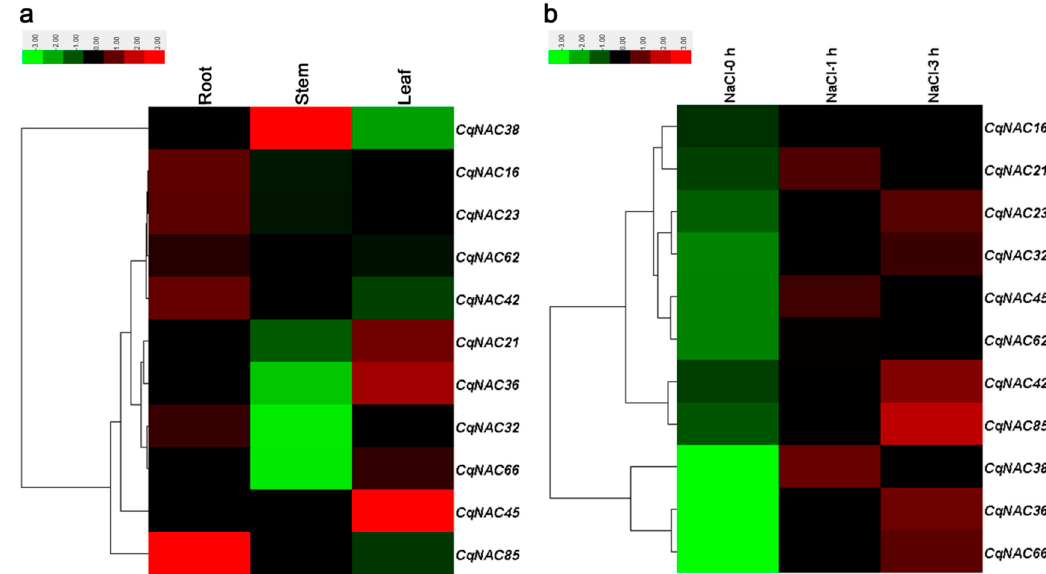
Figure 4. Expression profiles of 11 CqNAC genes in different tissues ( a ) and in root under salt stress treatment ( b ). The color bar at the top of the heat map represents relative expression values.